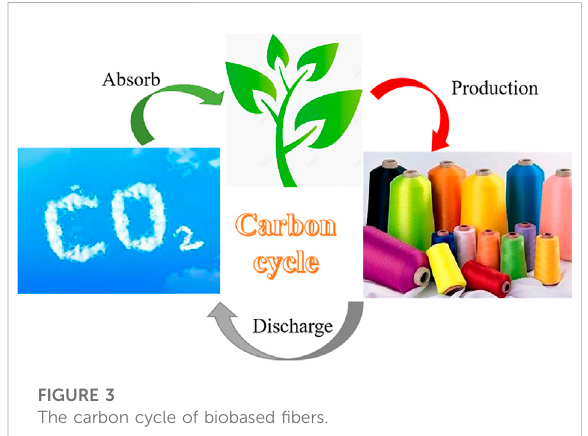
FIGURE 3 The carbon cycle of biobased fi